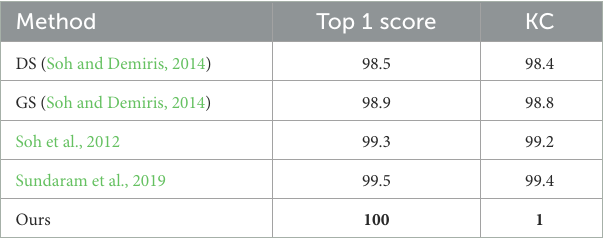
TABLE 5 Comparisons with the state-of-the-art methods in terms of top 1 score ( % ) and KC ( % ) on the iCub